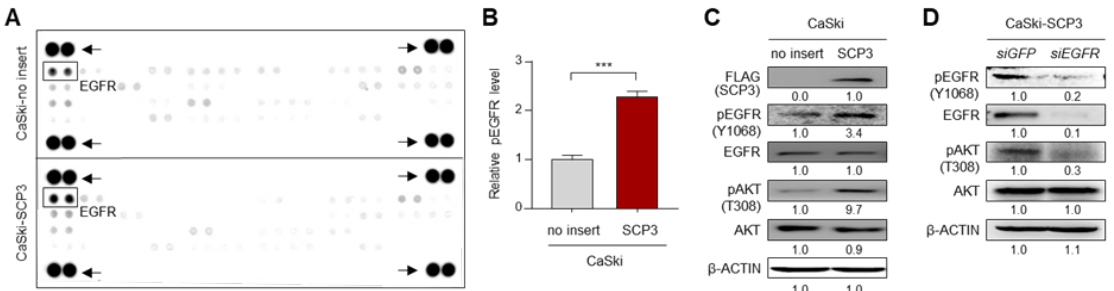
Figure 1. EGFR is an upstream signaling pathway responsible for SCP3-induced AKT activation. ( A , B ) The phosphorylation status of RTKs in CaSki-no insert and CaSki-SCP3 cells was assessed by Human phospho-RTK array. ( A ) Representative dot images from the phospho-RTK array. Boxes indicate the spots corresponding to the levels of phosphorylated EGFR. Arrows indicate the reference spots on the array blot, as a loading control. ( B ) The graph represents quantification for relative level of pEGFR on the array blot. The data represent the mean ± SD. *** p ≤ 0.001, by unpaired, two-tailed Student’s t -test. ( C ) The levels of pEGFR, EGFR, pAKT and AKT in CaSki- no insert and CaSki-SCP3 cells were confirmed by Western blots. ( D ) CaSki-SCP3 cells were transfected with siGFP or siEGFR . Levels of pEGFR, EGFR, pAKT and AKT were analyzed by Western blots. ( C , D ) β -ACTIN was used as an internal loading control. Numbers below blot images indicate fold-change in protein level. All experiments were performed in